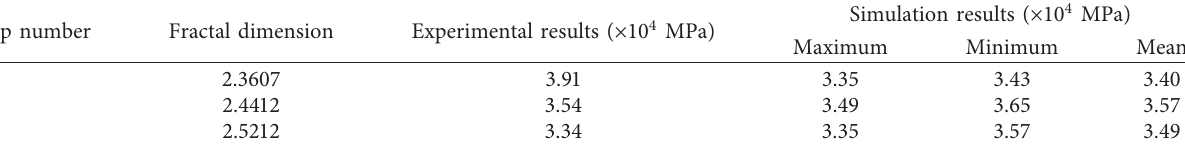
Table 3: Comparison of simulation and experimental results.